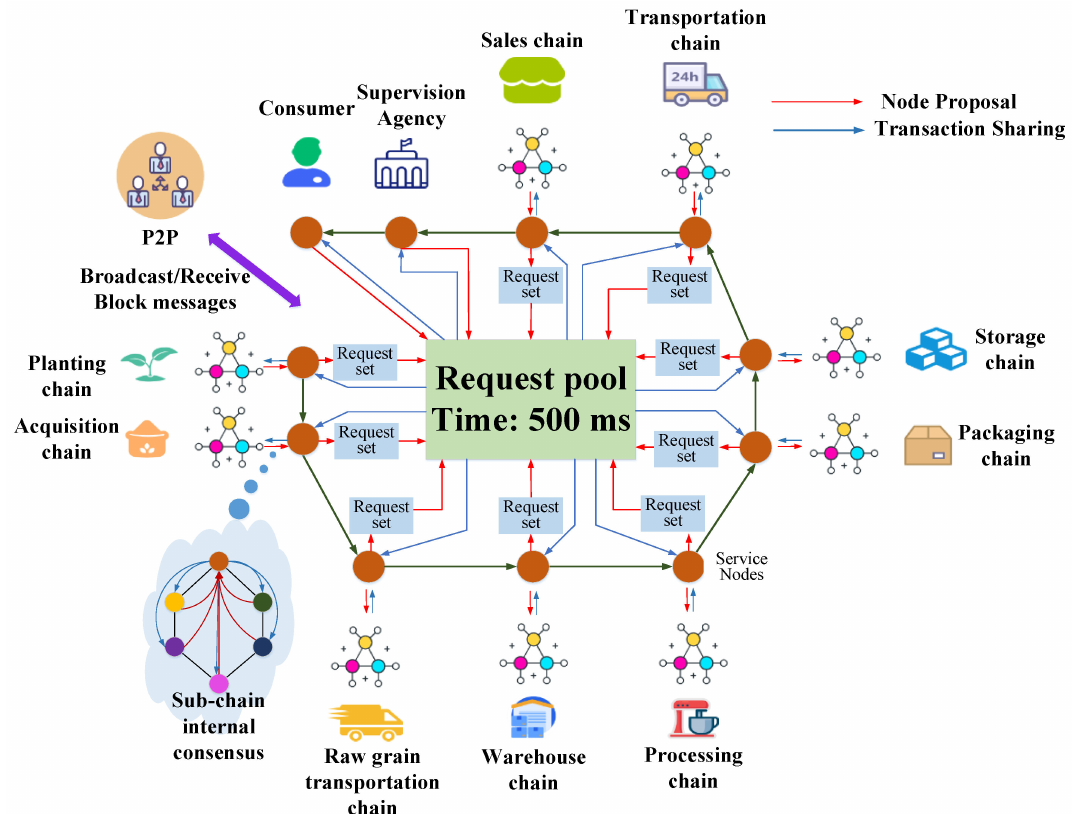
Figure 5. Schematic diagram of SPOP consensus